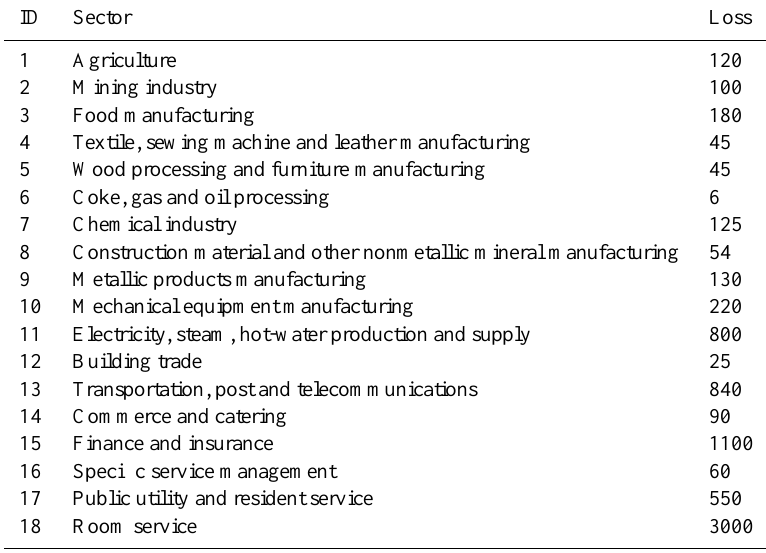
Table 1. Direct economic loss due to the Wenchuan Earthquake distributed by sectors in Sichuan (Unit CNY100 million). ID